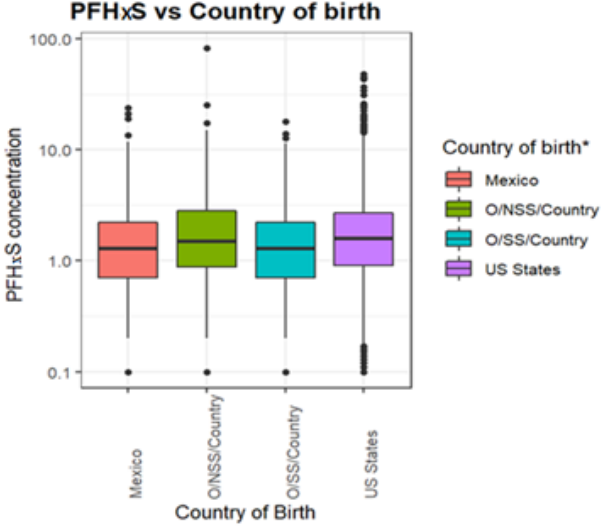
Figure 2. PFHxS (ng/mL) levels by county of birth. * Note: Mexico is Mexican born, US States is U.S born, Other Spanish Speaking County is O/SS/Country, Other Non-Spanish Speaking Country is O/NSS/Country.